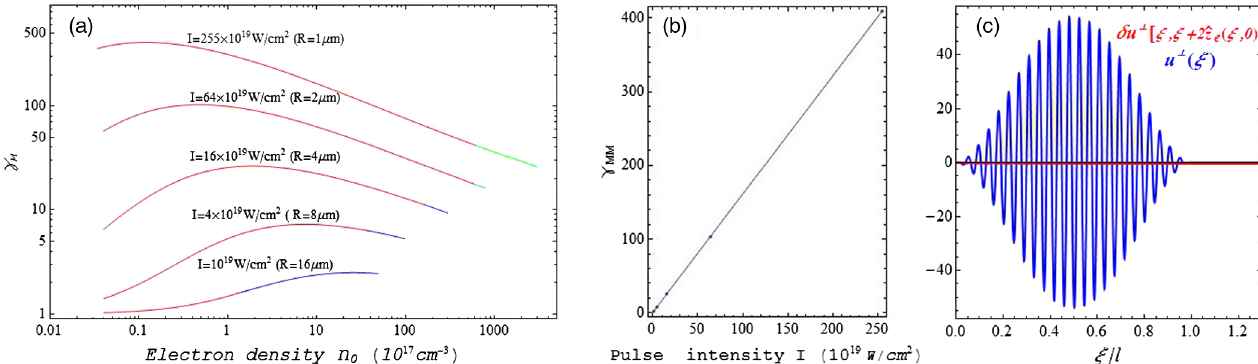
FIG. 9. (a) relativistic factor γ of the Z ¼ 0 expelled electrons (the maximal one) as a function of the step-shaped initial electron M density n 0 , for few values of the intensity I ; the maximum of each graph is denoted as γ along the X ¼ 0 electrons ’ worldlines for n 0 ¼ 24 × 10 19 cm − 3 , I ¼ 255 × 10 19 W = cm 2 : δ u ⊥ is